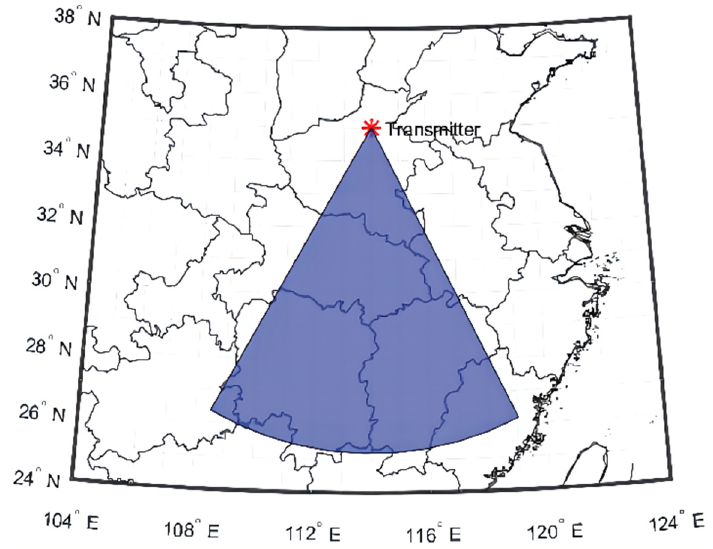
Figure 3. The position of the transmitter.